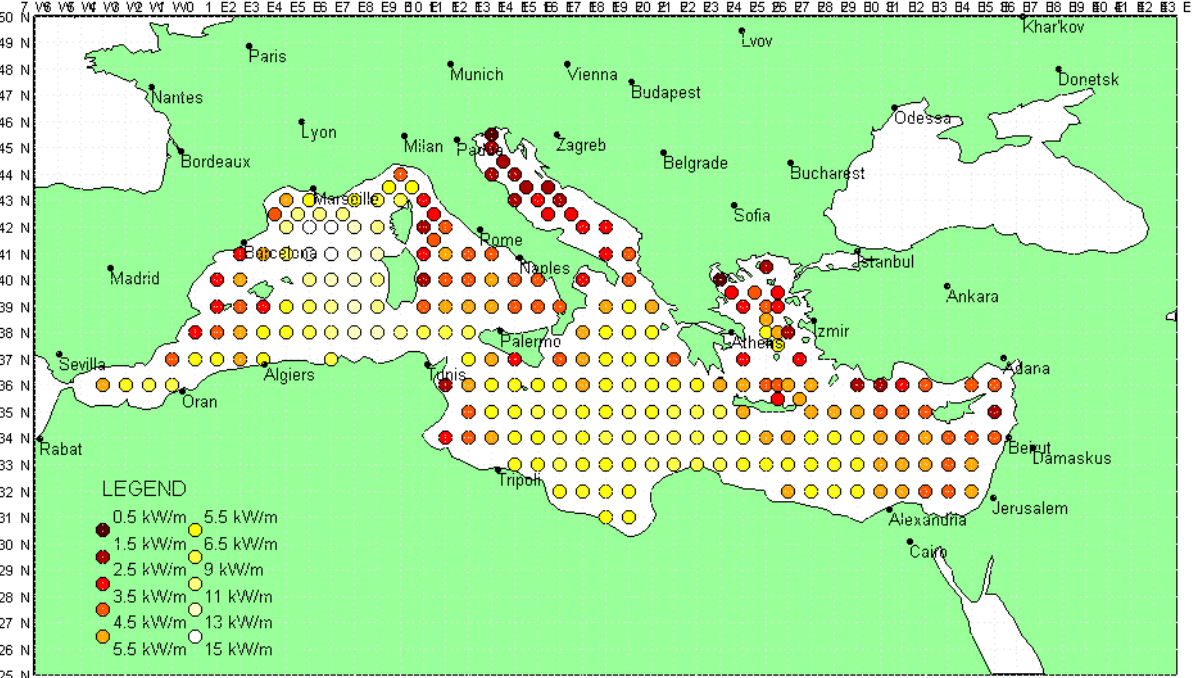
Figure 2. Energy flux per unit span, integrated for all